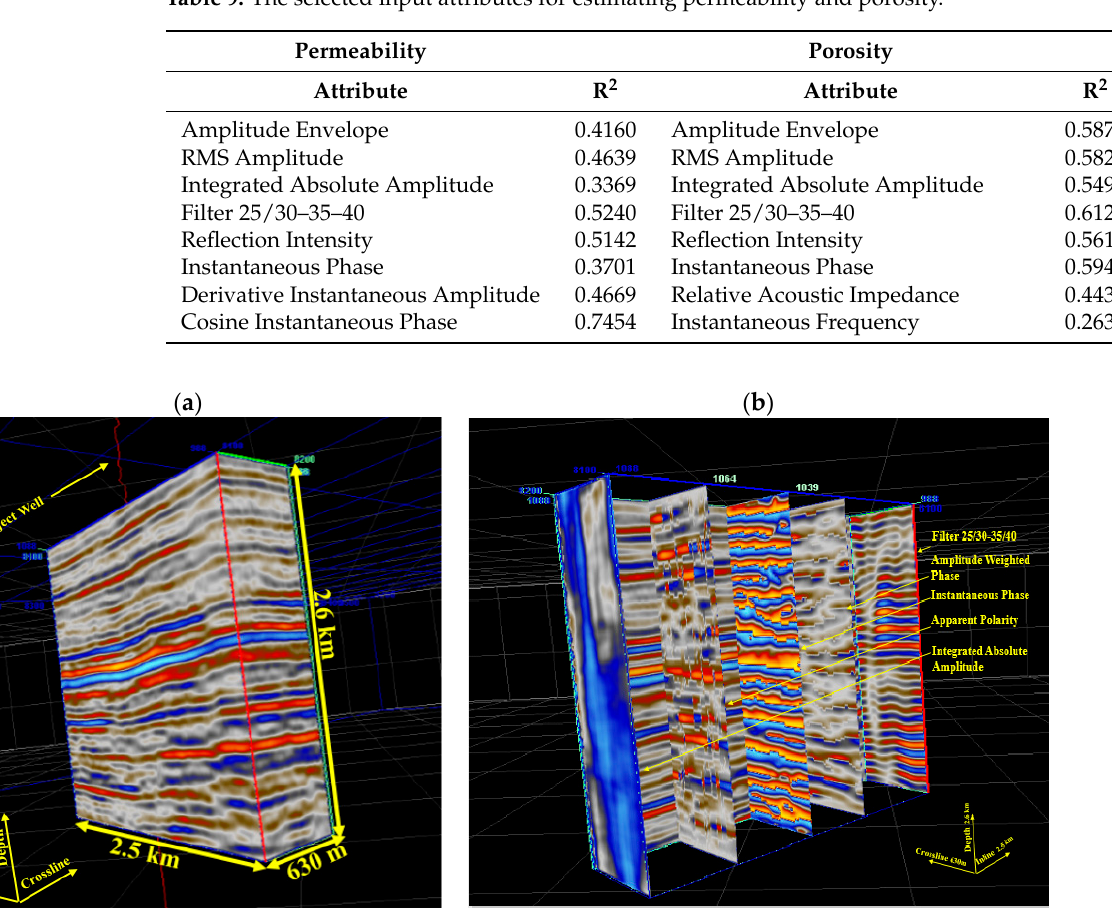
Figure 17. ( a ) 3D seismic cube used for extracting the employed attributes at the well location; ( b ) Employed seismic attributes. Table 10. Properties of the employed data pairs for estimating petrophysical properties from the seismic attributes by both statistical and deep learning models.